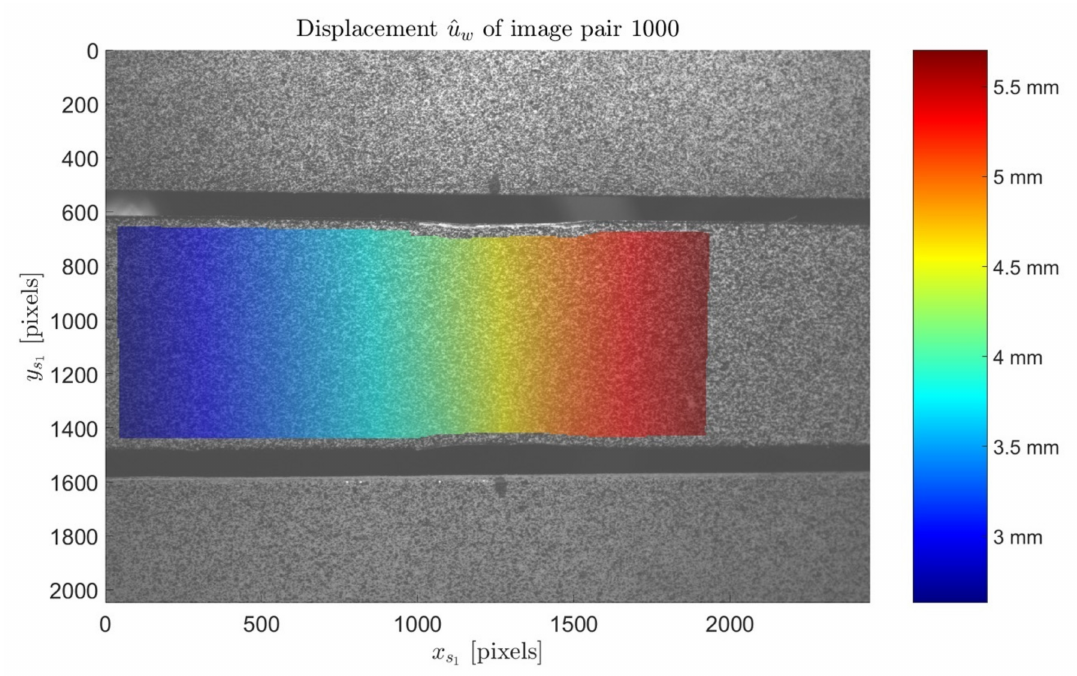
Figure 4. Displacement in the x-direction in the world CS superimposed on the FIS1 of the ASTM tensile specimen